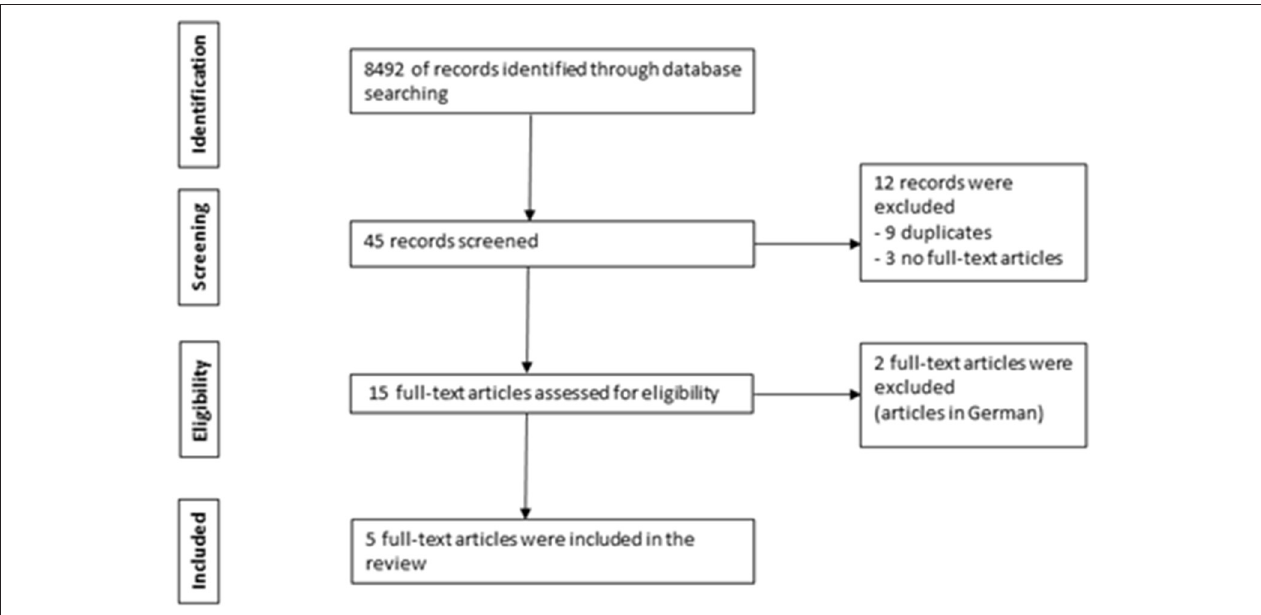
FIGURE 1 | Flowchart of the review article selection